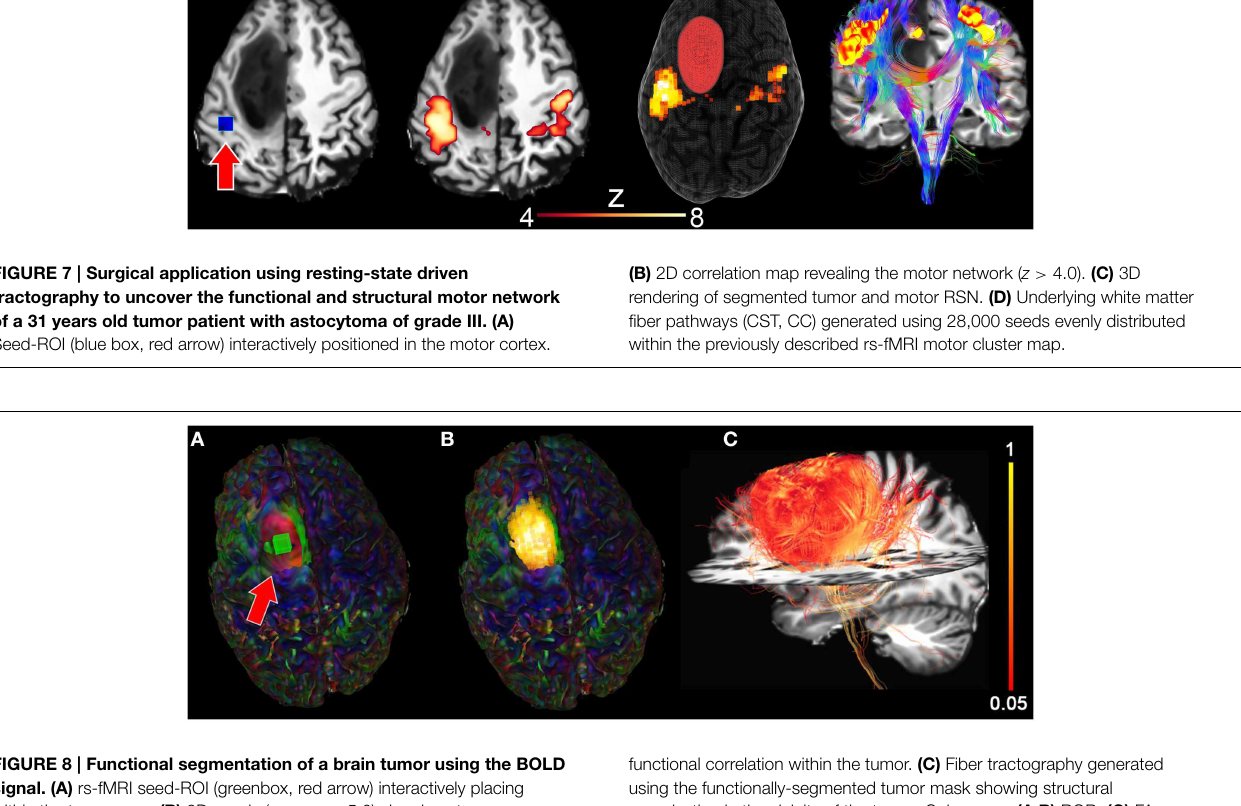
FIGURE 8 | Functional segmentation of a brain tumor using the BOLD signal. (A) rs-fMRI seed-ROI (greenbox, red arrow) interactively placing within the tumor area. (B) 3D voxels ( z -score > 5.0) showing strong